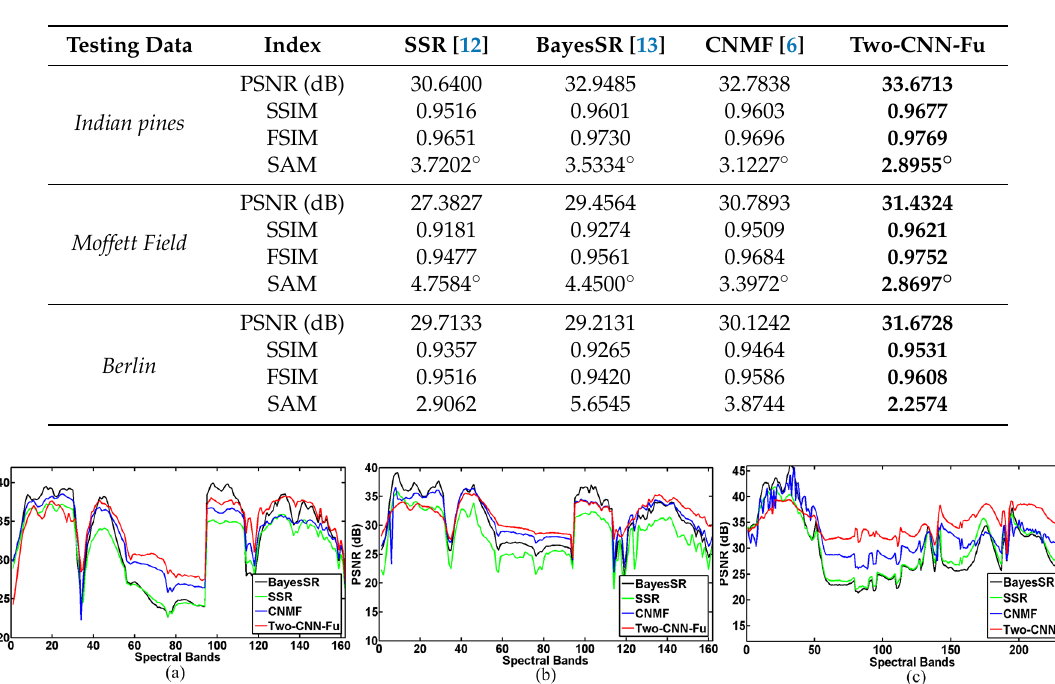
Table 4. The evaluation indices of different fusion methods on the three testing data by a factor of four.